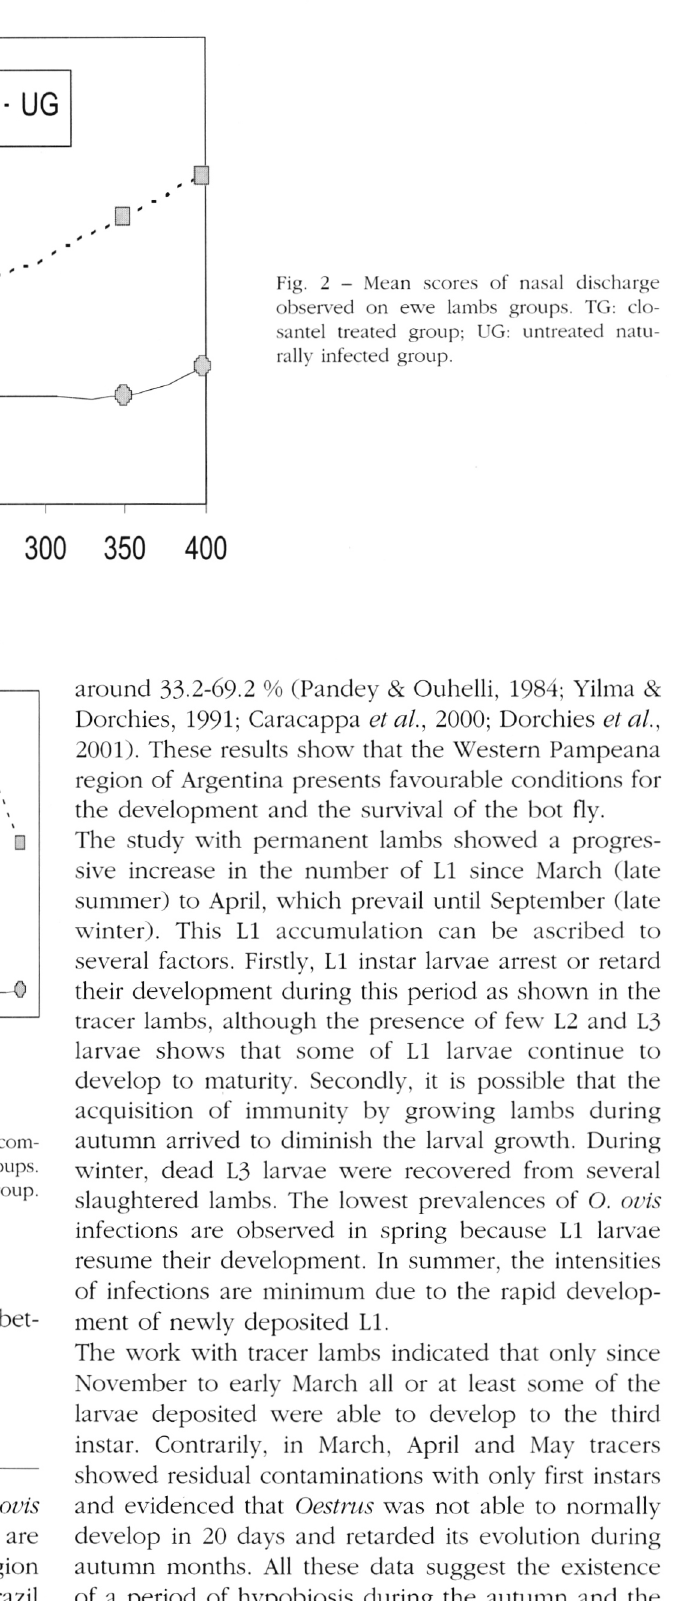
Fig. 2 - Mean scores of nasal discharge observed on ewe lambs groups. TG: clo- santel treated group; UG: untreated natu­ rally infected group.